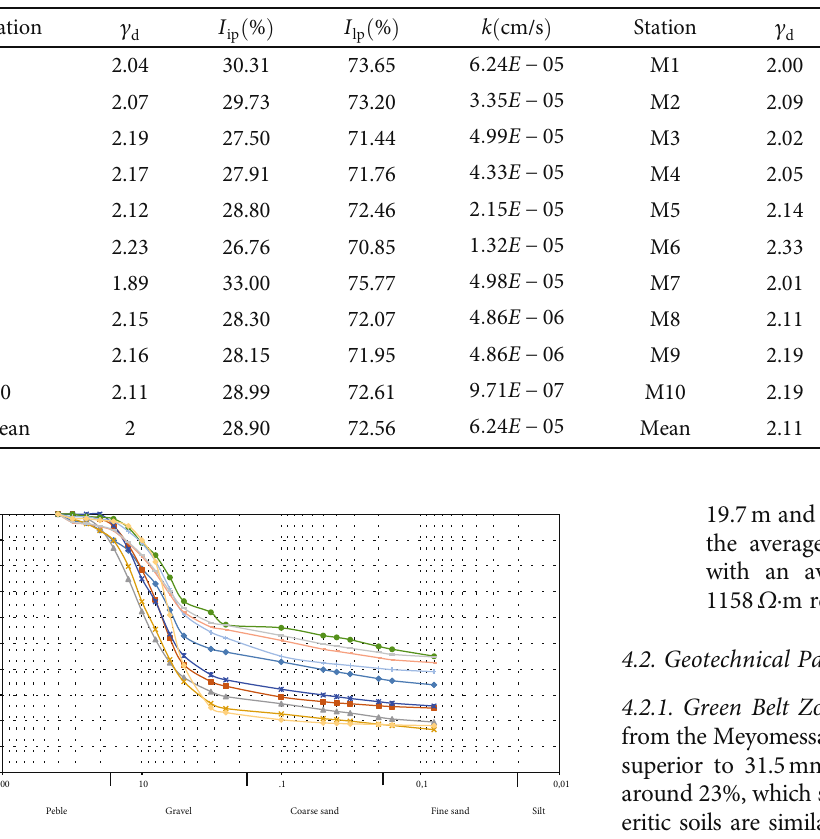
Figure 4: Sieve analysis of laterite in the green belt zone.